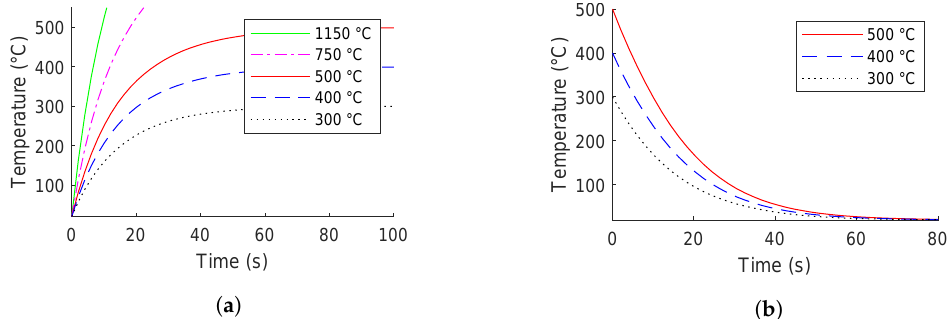
Figure 8. Simulation results of furnace heating and cooling; Legend values represent furnace temper- ature ( a ) or initial temperature ( b ).